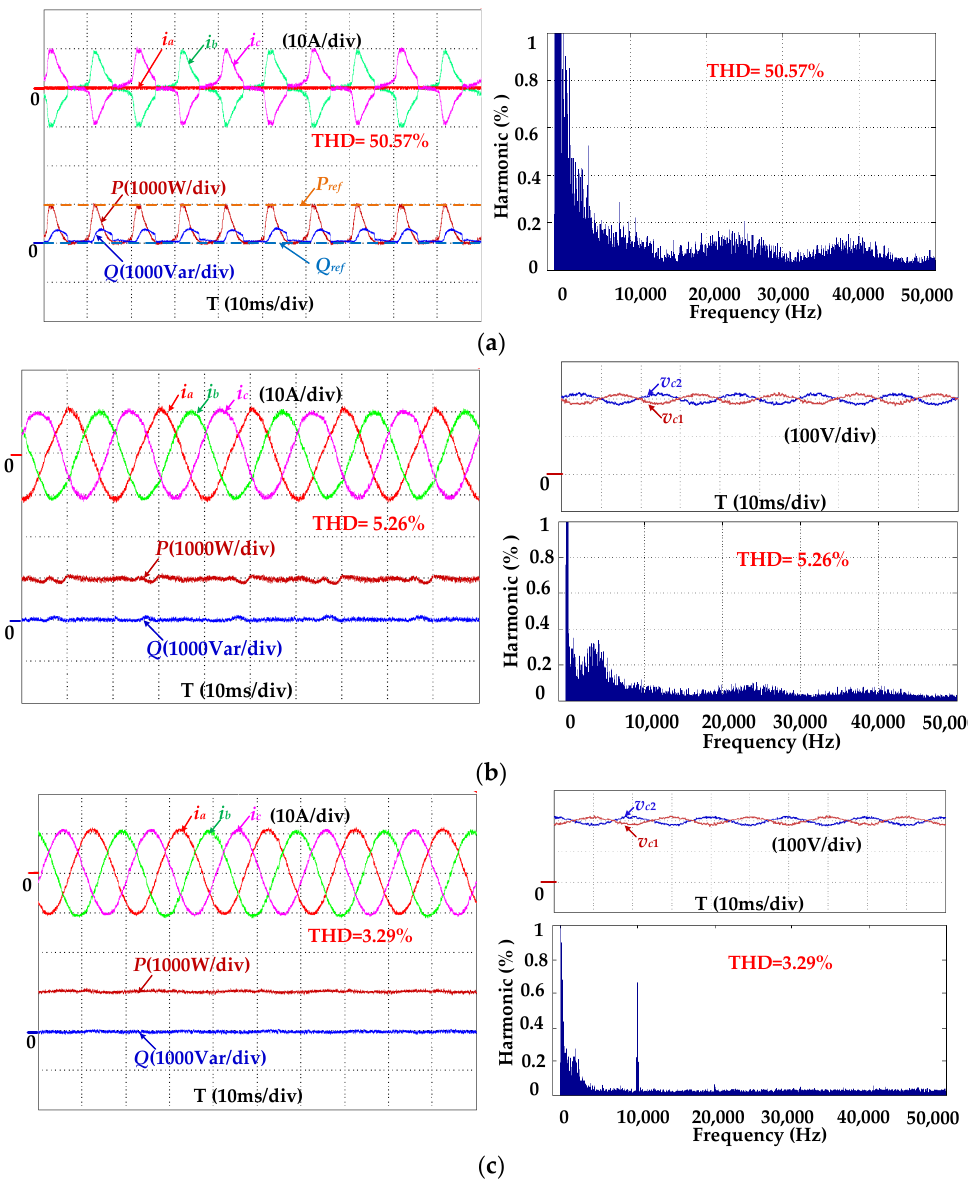
Figure 12. Experimental results of BVSC with a Phase A fault in inverter mode. ( a ) MPDPC for BVSC. ( b ) MPDPC for a TPFS converter. ( c ) Proposed CF-MPDPC for a TPFS converter.